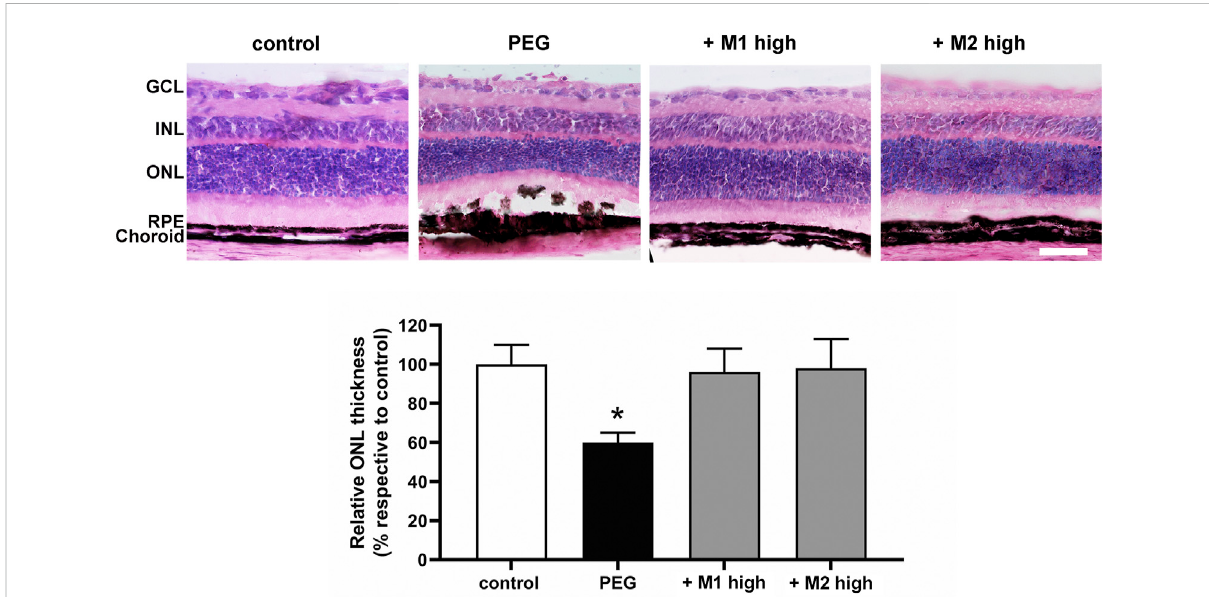
FIGURE 6 Effect of M1 and M2 on PEG-induced retinal damage. Representative images of H/E-stained retinal cross sections of controls, PEG-injected mice untreated, PEG-injected mice treated with the high doses of either M1 or M2. Morphometric analysis of the ONL thickness normalized to the total retinal thickness and expressed as percentage of controls. Data are expressed as mean ± SEM. Differences among groups were assessed using one-way ANOVA followed by Tukey ’ s multiple comparison post-hoc test (N = 6). * p < 0.05 vs. control. Scale bar, 50 μ m. GCL, ganglion cell layer; INL, inner nuclear layer; ONL, outer nuclear layer; RPE, retinal pigment